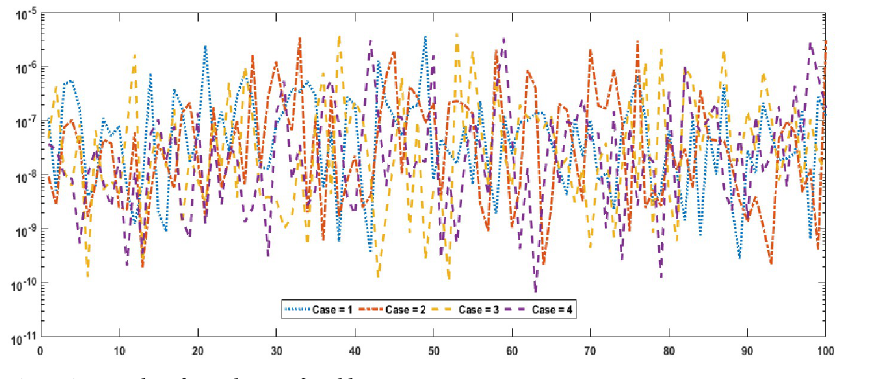
Fig 6. Fitness values for each case of problem 1.